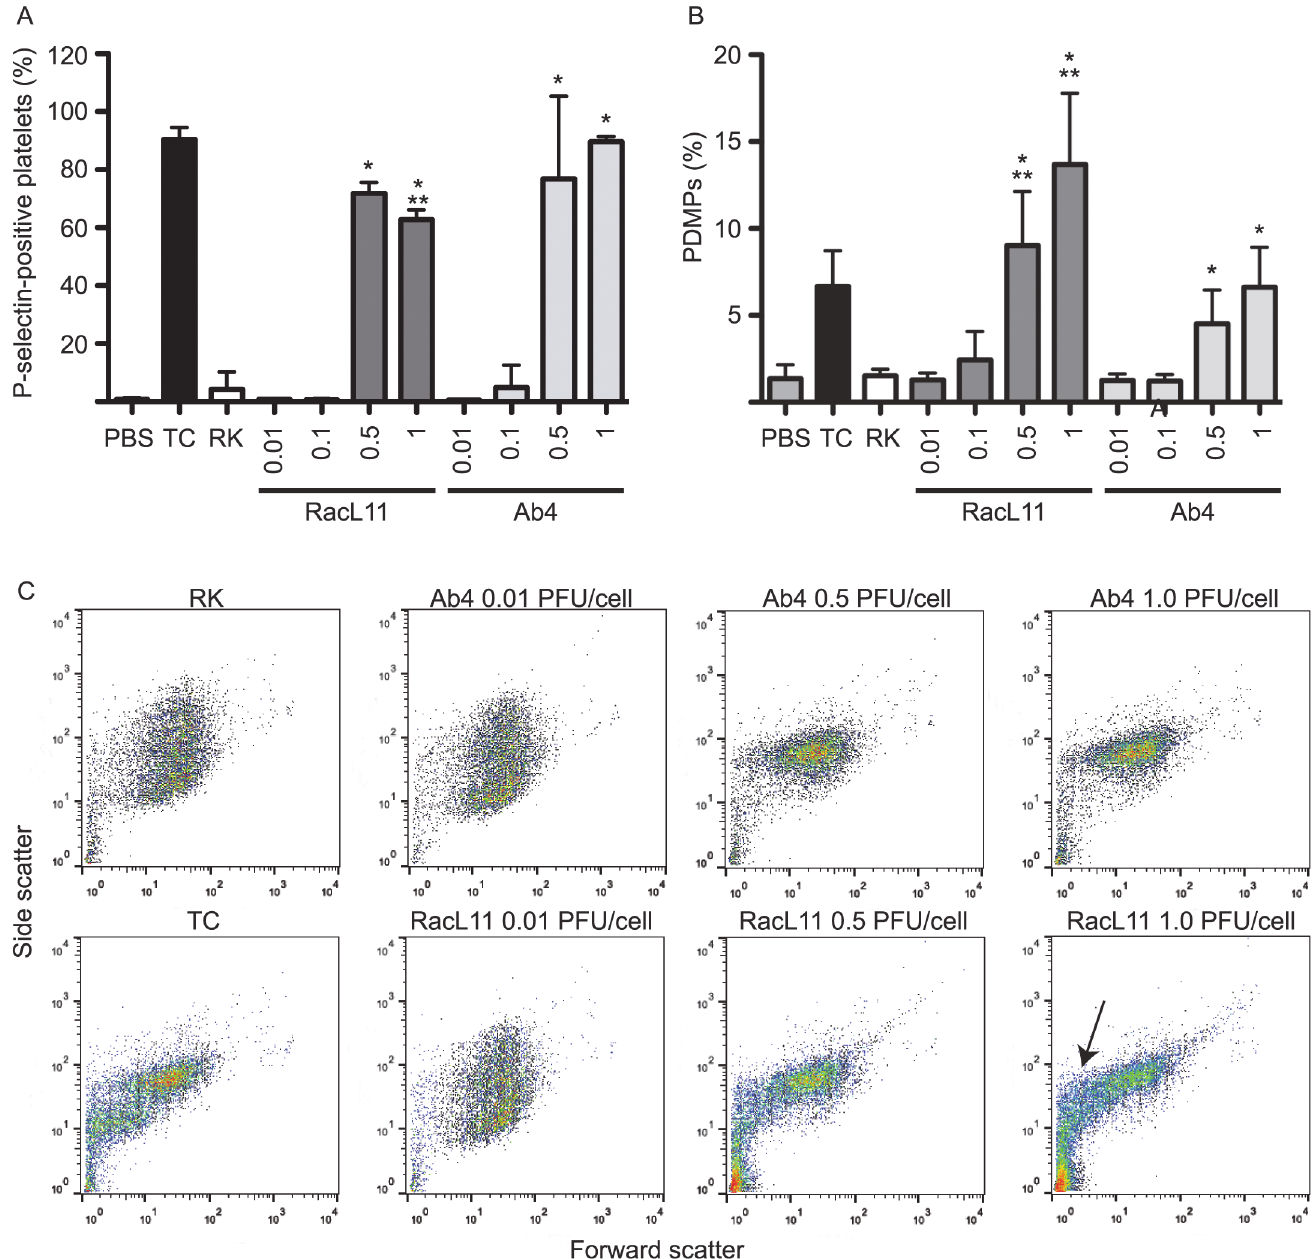
Fig 3. EHV-1 induces platelet P-selectin expression and shedding of platelet-derived microparticles in equine platelet-rich plasma. Platelets were exposed for 10 minutes to RacL11 or Ab4 EHV-1 strains at increasing PFU/cell (0.01, 0.1, 0.5, or 1) with PBS and RK lysate as negative controls and thrombin-convulxin (TC, 0.15 U/mL-0.05 ug/mL) as a positive control. Then the mean percentage ± SD of platelets positive for P-selectin ( A ) and PDMPs ( B ) were quantified (n = 8). At the higher PFU/cell of 0.5 and 1, both strains induced P-selectin expression and microvesiculation, along with compaction and narrowing of the platelet event cloud and increased small events on forward and side scatter dotplots ( C ). Microvesiculation was more prominent with RacL11 (B, C arrow). Exposure to both viruses at 5 PFU/cell replicated these findings, demonstrating a dose-dependent platelet activation response ( S1 Fig ). * p (cid:3) 0.01 versus PBS or RK negative controls for each strain. ** p < 0.001 versus TC or Ab4 at 0.5 or 1 PFU/cell.